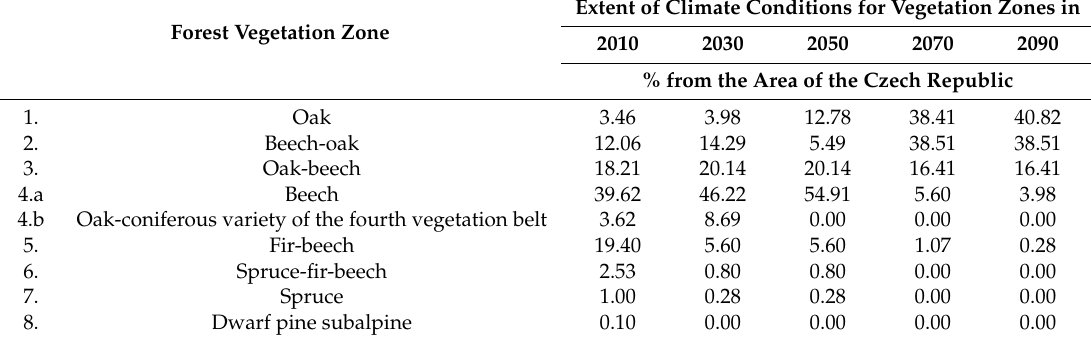
Table 1. Current extent and future areas with projected climatic characteristics corresponding to the respective forest vegetation zones of the Czech